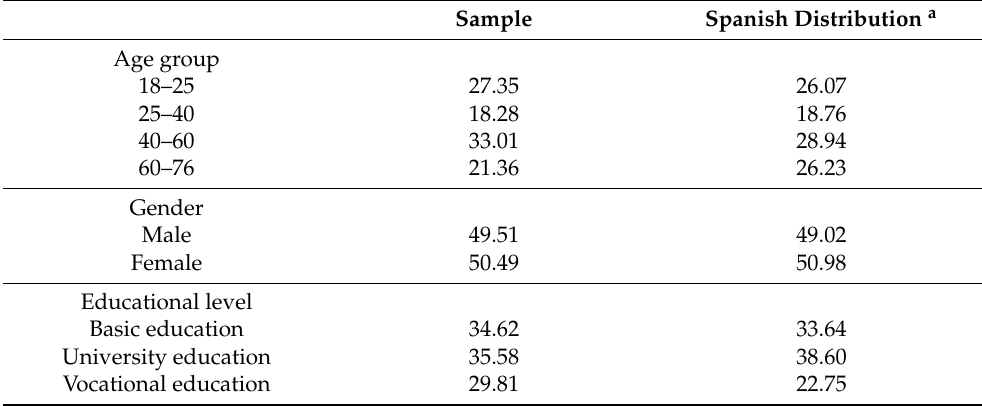
Table 1. Demographic characteristics of consumers and the Spanish